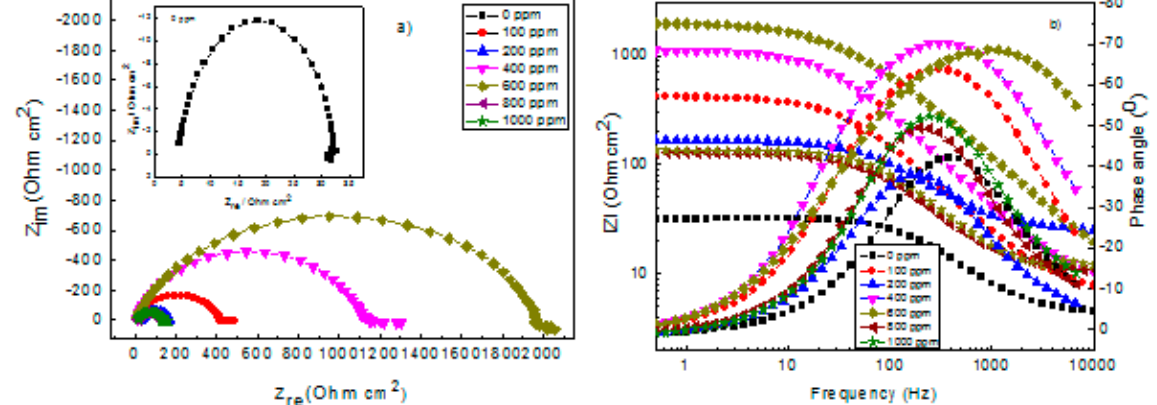
Figure 6. Effect of α -linolenic acid concentration in the ( a ) Nyquist and ( b ) Bode diagrams for 1018 carbon steel in 0.5 M H 2 SO 4 .